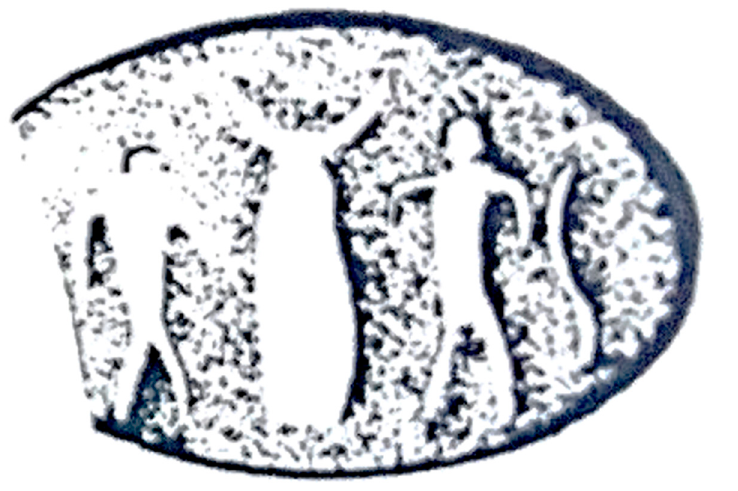
Figure 2. Tell el-Far ‛ ah seal impressed handle, depicting figures flanking a lunar crescent on a pole (Keel 2010, pp. 6–7, no.